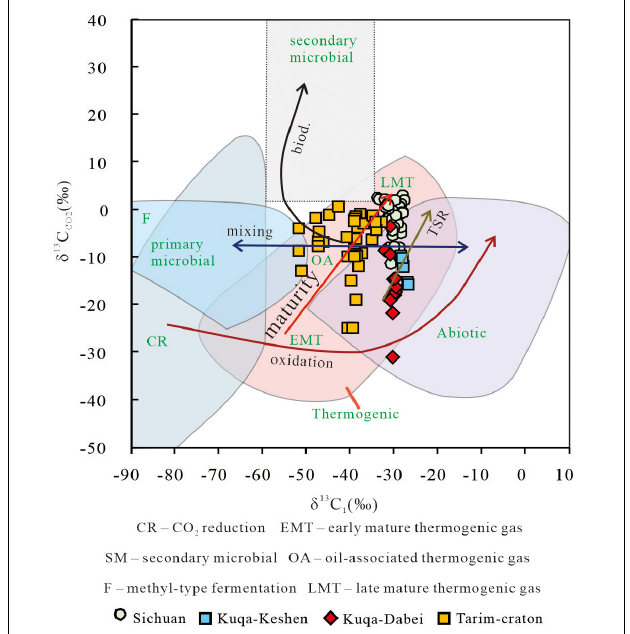
FIGURE 5 | Genetic diagram of δ 13 C CO2 vs. δ 13 C 1 of gases from Dabei and Keshen gas fields in the Kuqa depression, craton area of Tarim Basin and Sichuan Basin, China (Milkov and Etiope, 2018). Data source see section “Samples and Methods” in the text.